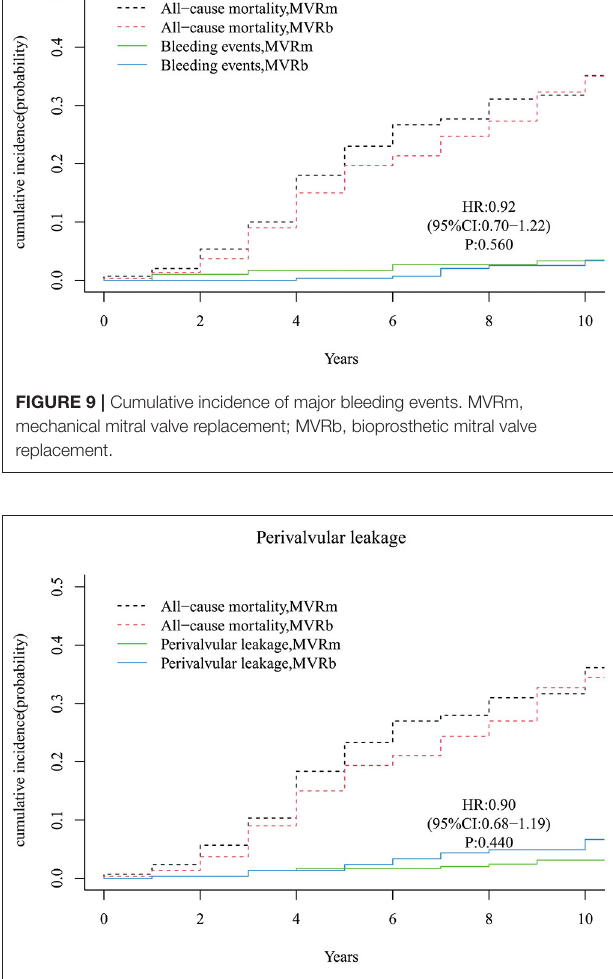
FIGURE 10 | Cumulative incidence of perivalvular leakage. MVRm, mechanical mitral valve replacement; MVRb, bioprosthetic mitral valve